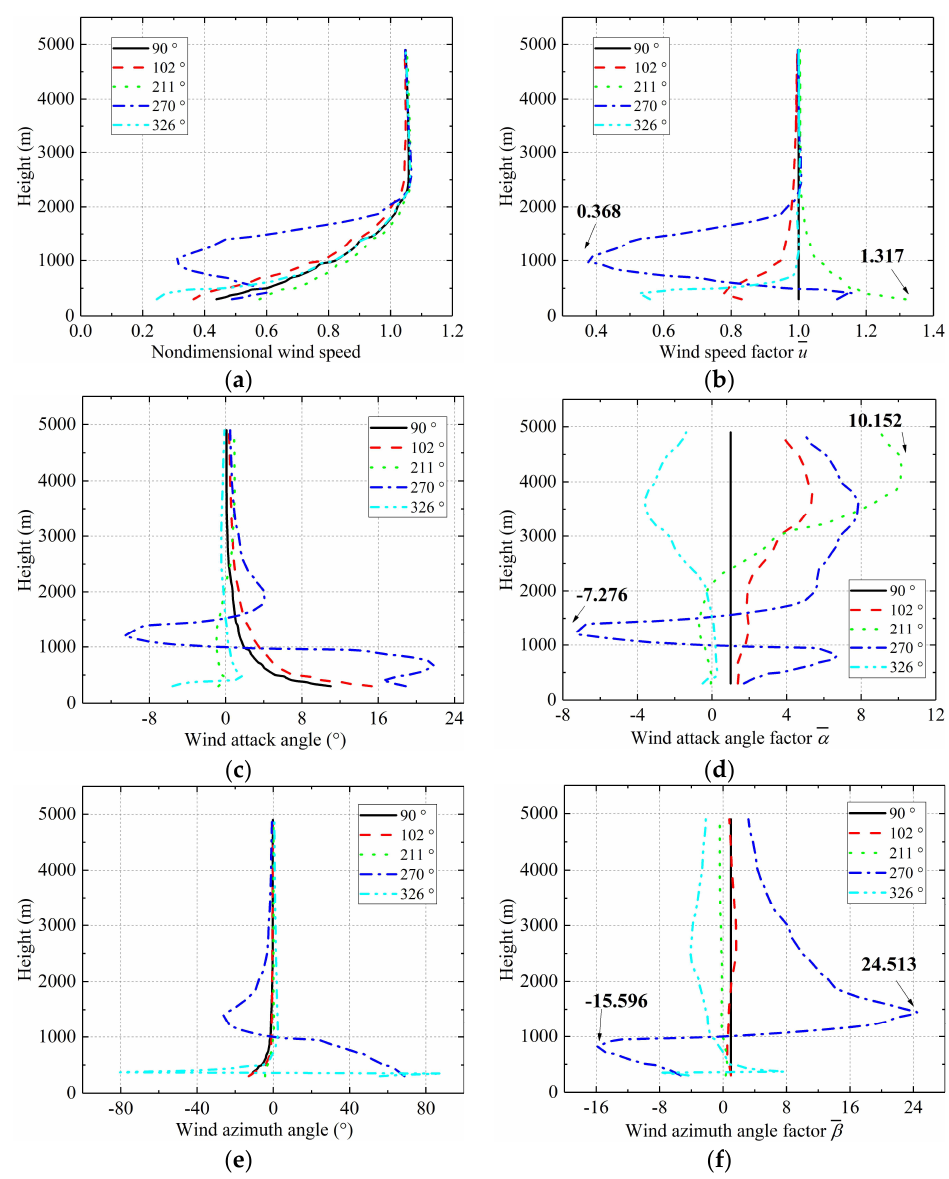
Figure 9. Influence of wind direction on wind parameters: ( a ) Nondimensional wind speed profile; ( b ) Nondimensional wind speed factor; ( c ) Wind attack angle profile; ( d ) Wind attack angle factor; ( e ) Wind azimuth angle; ( f ) Wind azimuth angle factor.